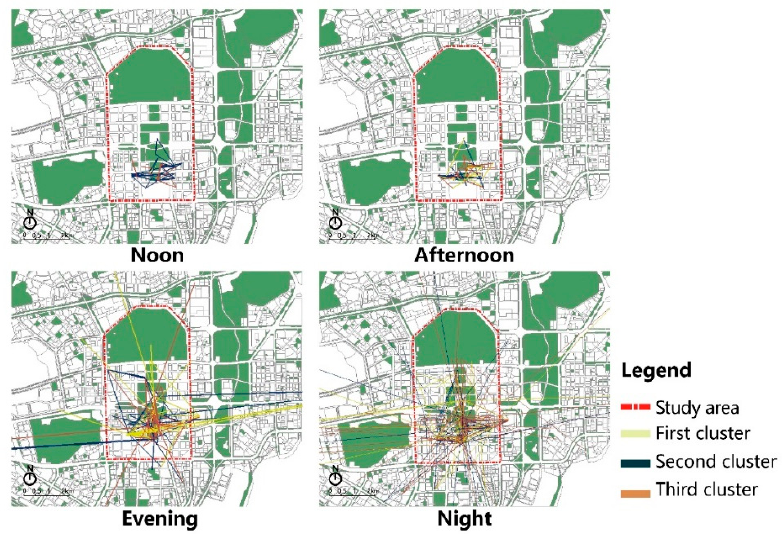
Figure 8. Path distribution map of green spaces use by clusters throughout the day.